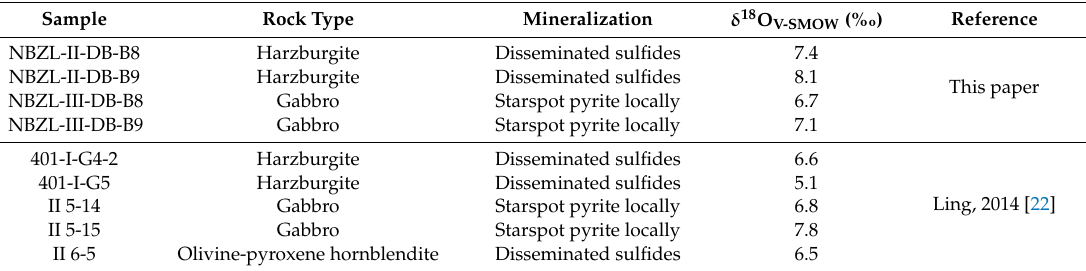
Table 4. The whole-rock oxygen isotopes of the Niubiziliang mafic-ultramafic complex. Sample Rock Type